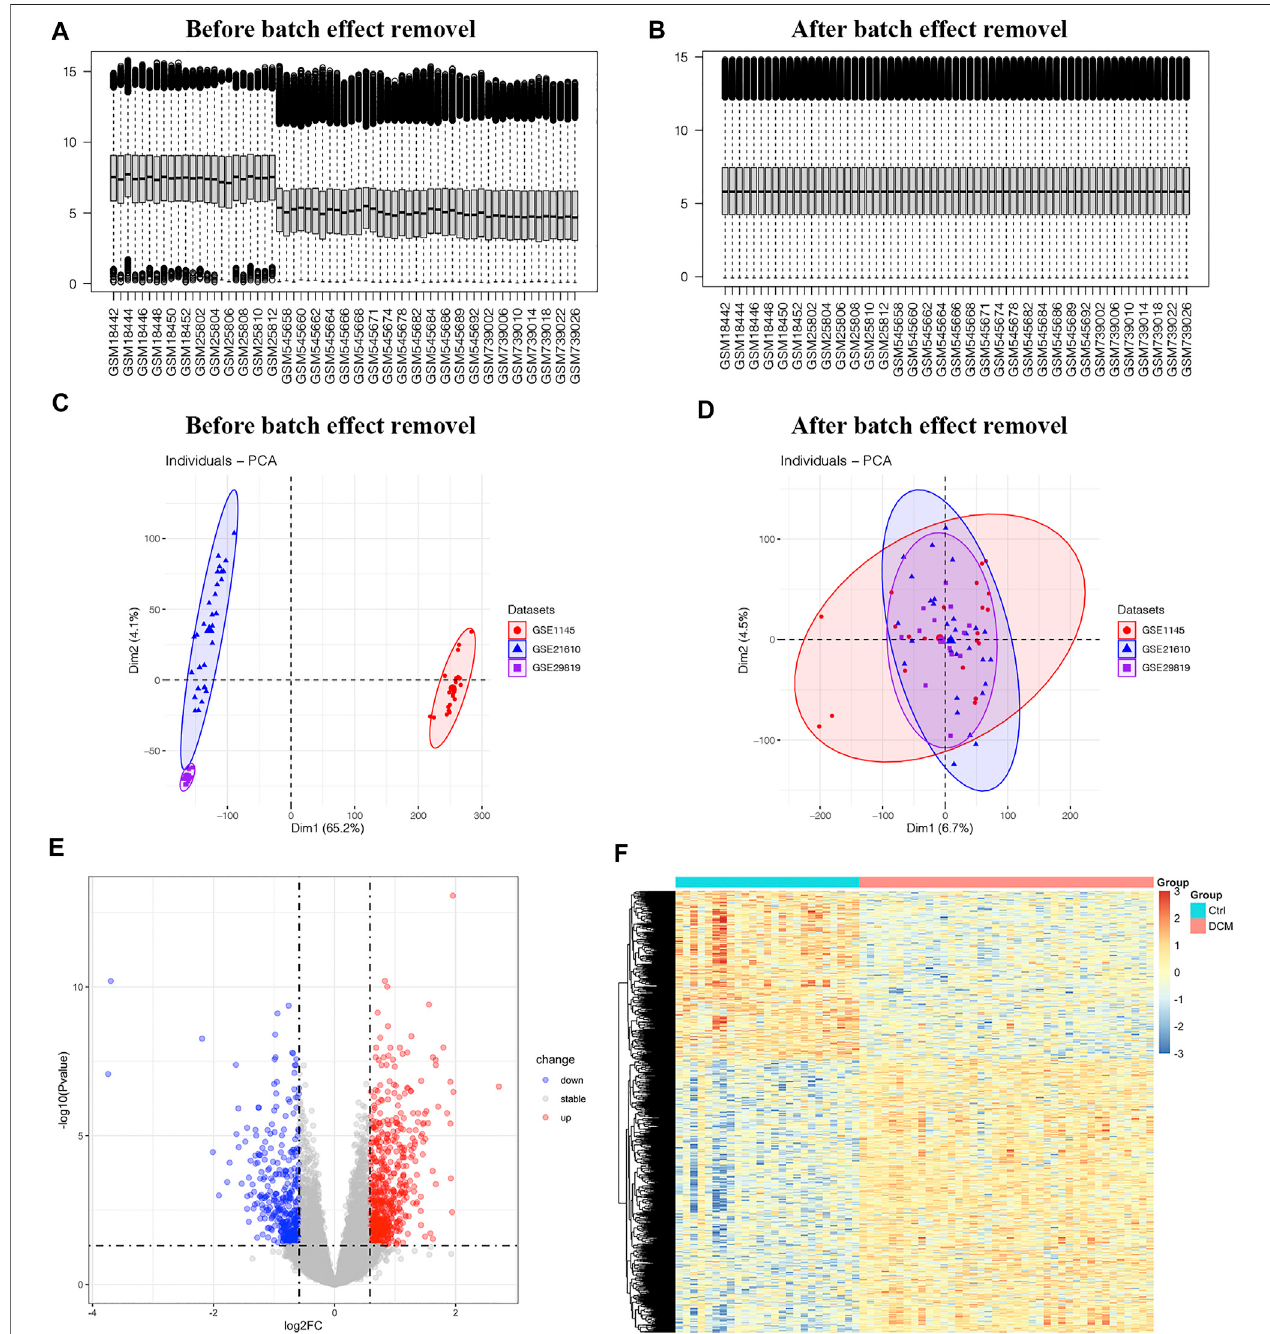
FIGURE 2 | The differentially expressed genes in merged dataset (A,B) The boxplot of merged dataset before and after normalization (C,D) Two-dimensional principal component analysis cluster plot before and after normalization (E) Volcano plot of 1,005 DEGs (F) Heatmap of all DEGs.